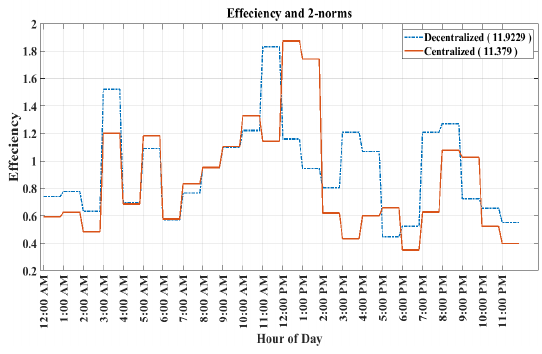
Fig. 19: Relative efficiencies of centralized and